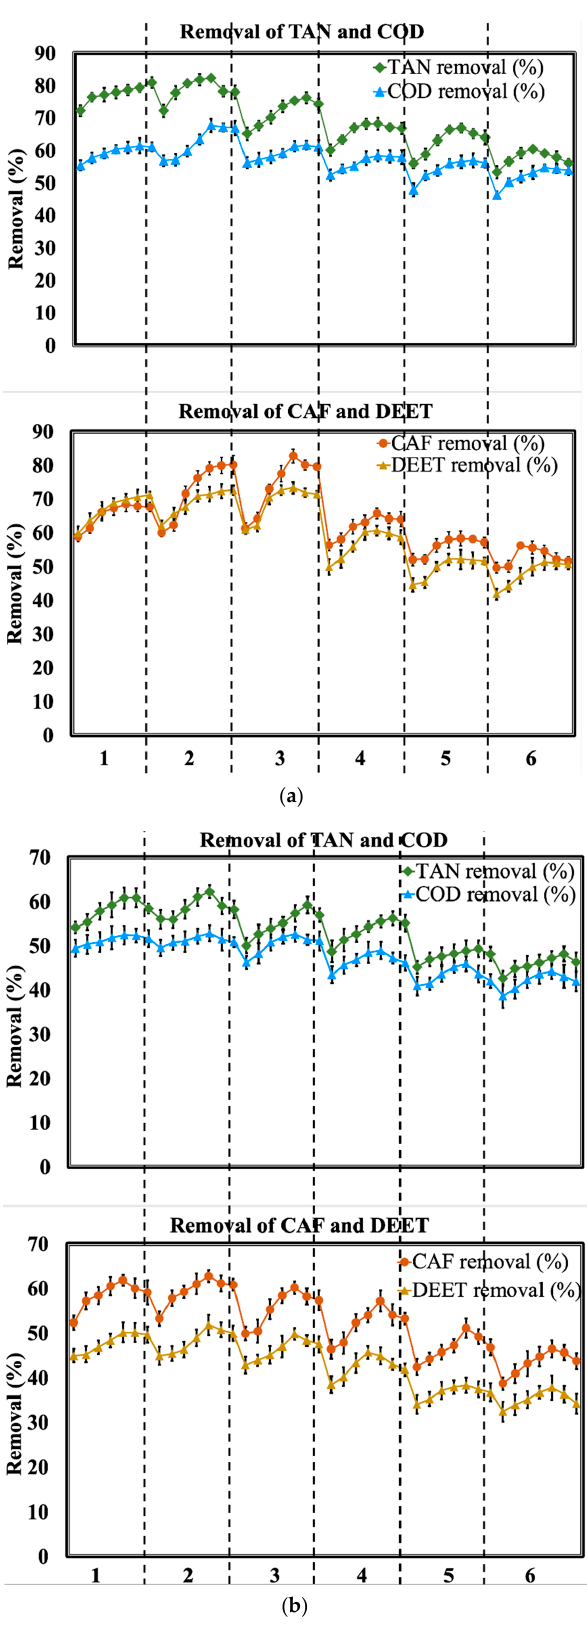
Figure 1. The performance of ( a ) reactor 1 and ( b ) reactor 2 in removing TAN, COD, CAF, and DEET.